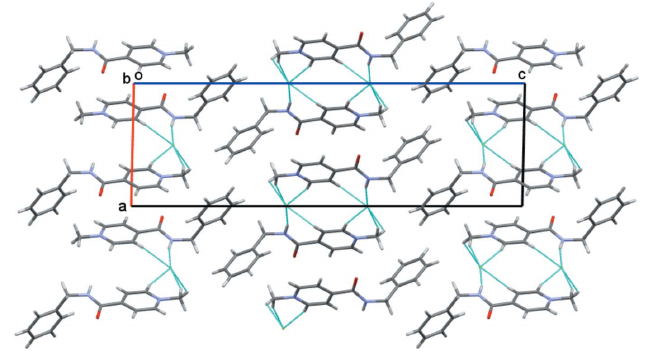
Figure 3 Crystal structure of 4-[(benzylamino)carbonyl]-1-methylpyridinium bromide. X —H (cid:2)(cid:2)(cid:2) Br hydrogen bonds are shown as dashed cyan